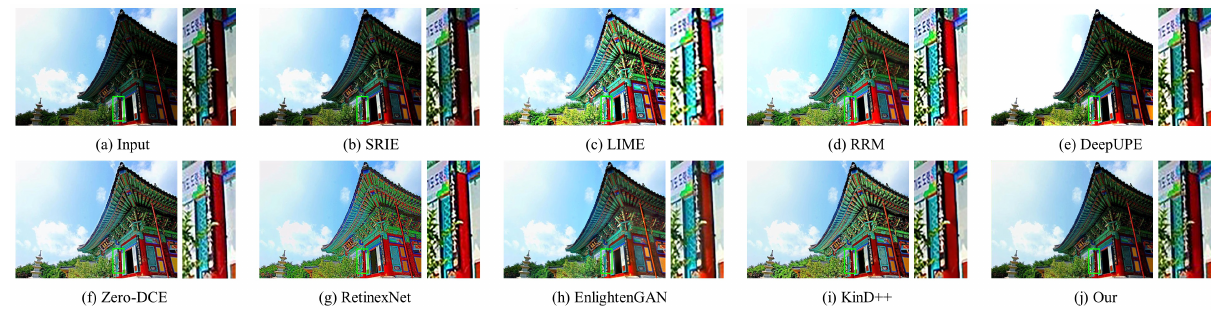
Figure 7. Visual comparison of low-light image enhancement on an image from the NPE dataset.